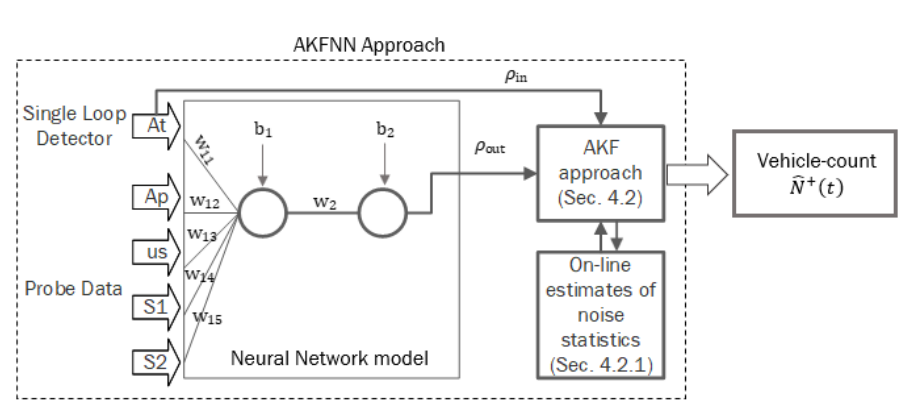
Figure 2. Flowchart for adaptive Kalman filter with a neural network (AKFNN)